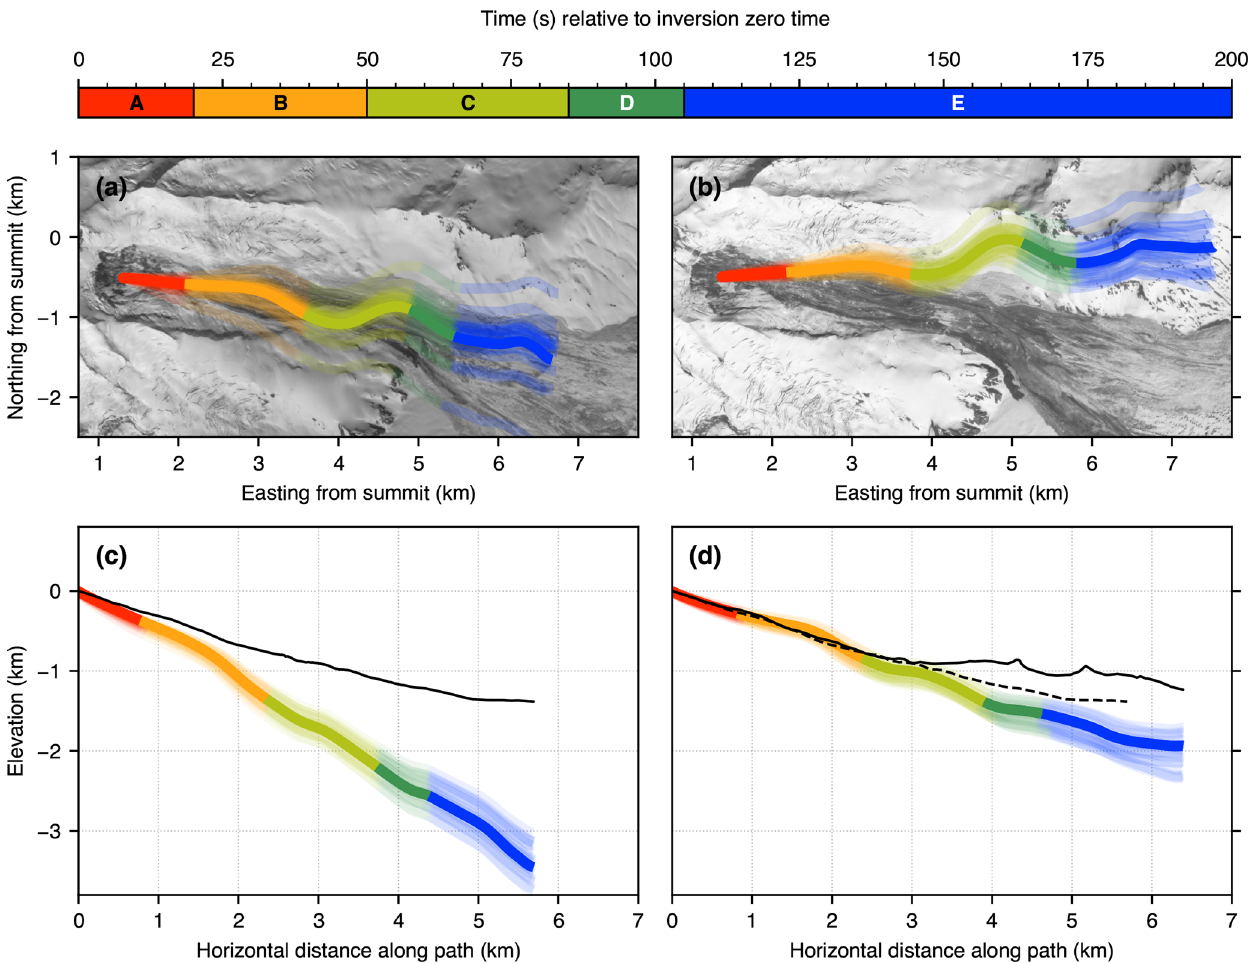
Figure 10. Map and profile views of trajectories integrated from the inversion force-time functions for the 2016 (a, c) and 2019 (b, d) events. Multiple translucent lines correspond to trajectories computed from the jackknife runs. Background images in (a) and (b) are the same as in Fig. 2. Black lines in (c) and (d) are profiles through the structure-from-motion digital elevation model (SfM DEM) along the corresponding horizontal trajectory. Dashed line in (d) is the SfM DEM profile from (c) . Colored segments correspond to those in Fig. 8 and the letters A–E in Sect. 6.2. Imagery © 2016 and 2019 Planet Labs,